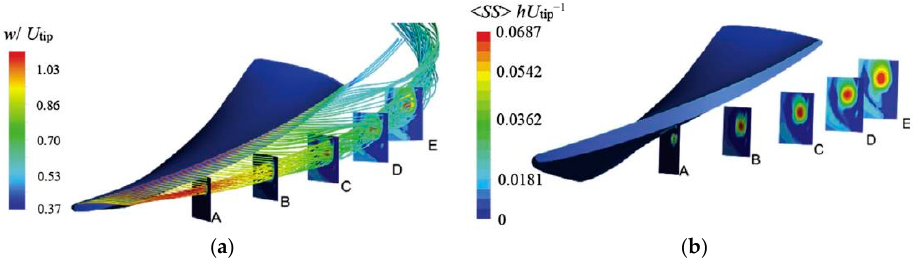
Figure 16. Streamlines and contours of swirling strength on different chord sections [42]. ( a ) Streamlines and swirling strength contours; ( b ) swirling strength contours.